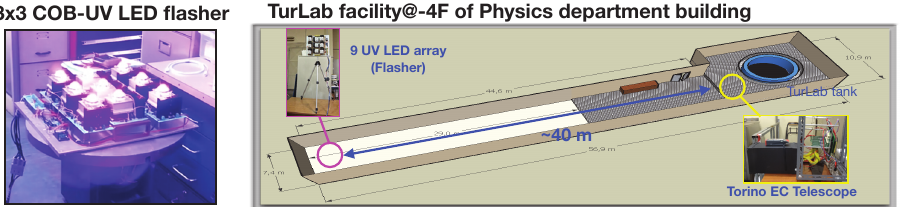
Figure 3: Left: 3 × 3 COB-UV LED flasher built in Turin. Right: schematic view of TurLab facility where the positions of the flasher and Torino EC telescope are indicated.